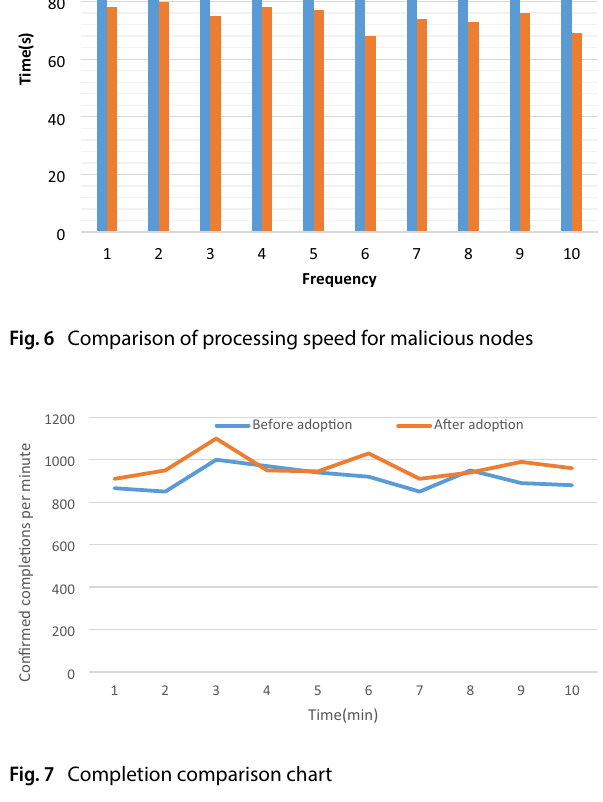
Fig. 7 Completion comparison